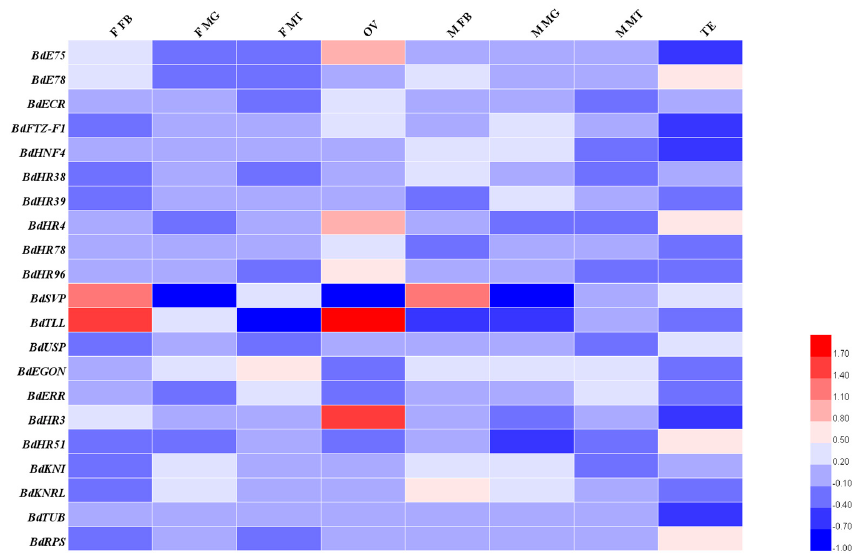
Figure 4. Tissue-specific expression of 19 B. dorsalis NR genes (excluding BdHR83 and BdDSF ) from four-day-old adults. Relative transcript levels were calculated using α -tubulin (GenBank